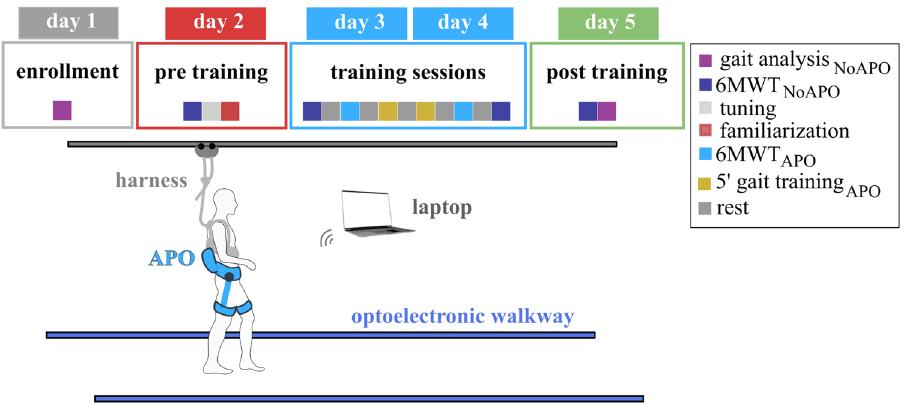
Figure 2. Experimental protocol and setup. The experimental protocol included 5 sessions, namely enrollment, pre-training, training (2x), and post-training sessions. In each session different gait tests and training were